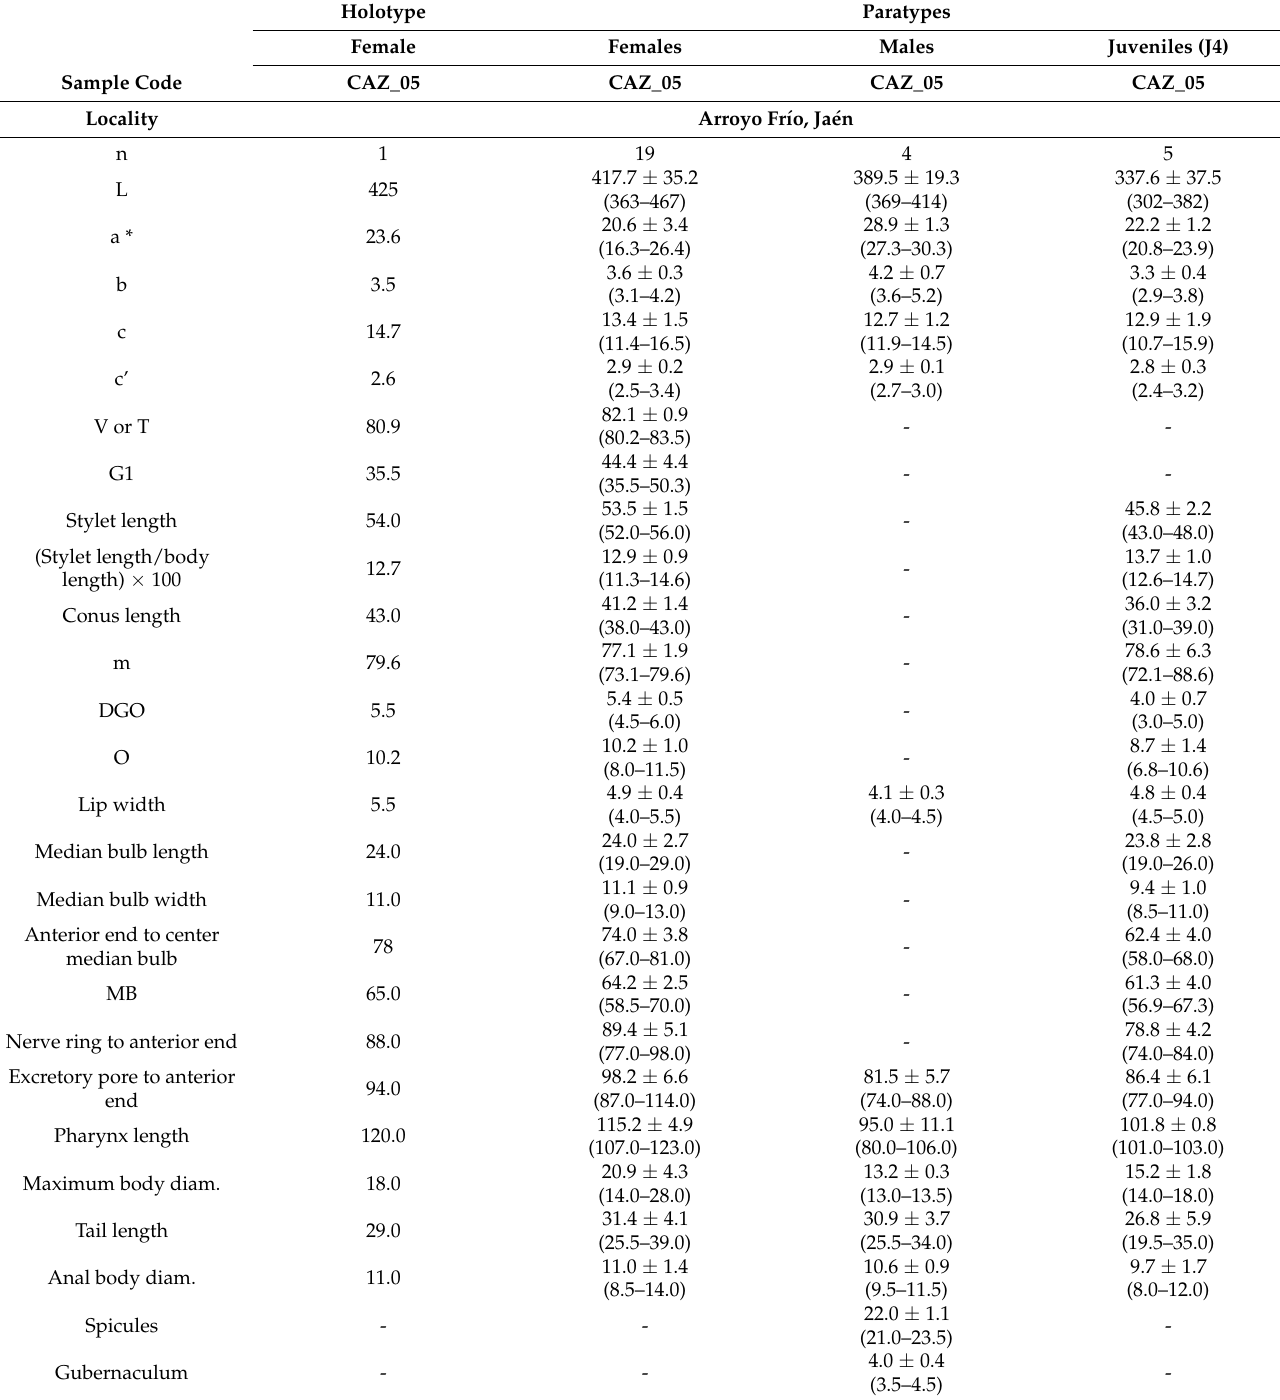
Table 2. Morphometrics of Paratylenchus parastraeleni sp. nov. paratype females, males and fourth-stage juveniles. All measurements are in µ m and in the form: mean ± s.d.